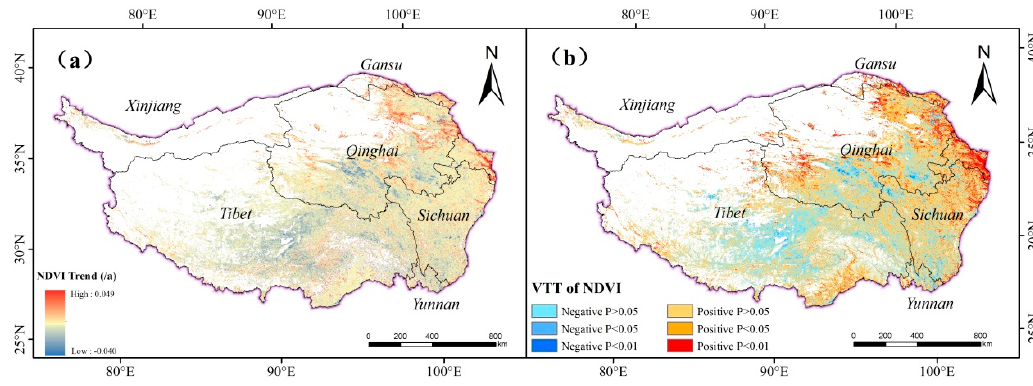
Figure 5. NDVI trend ( a ) and Variation Trend Types (VTTs) of NDVI ( b ) in TP from 2001 to 2017.